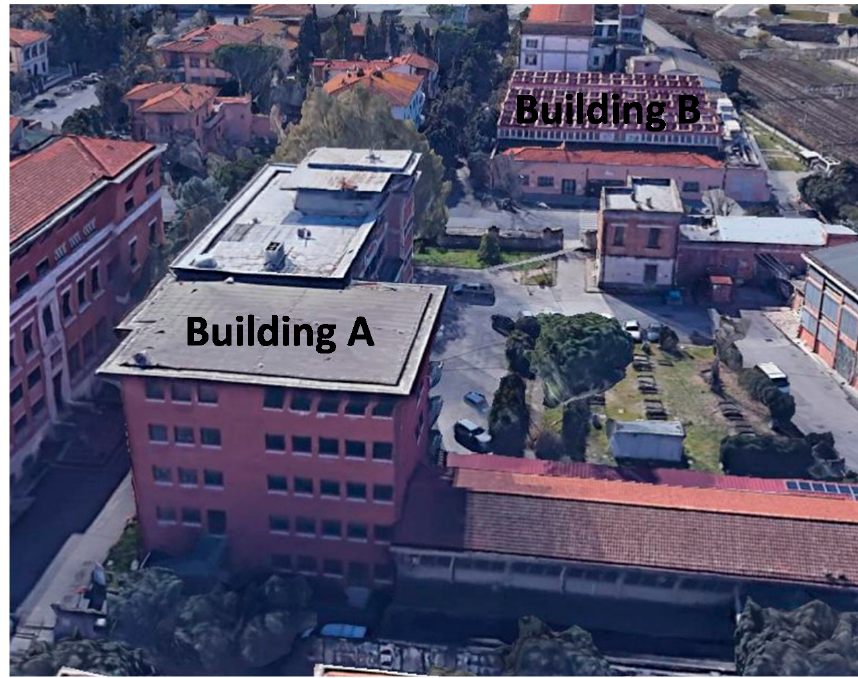
Figure 4. An aerial view of the two buildings, object of the analysis. Table 1. The main data of the two